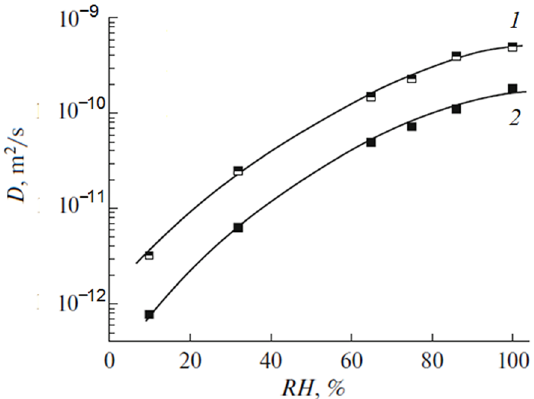
Figure 20. Average diffusion coefficients of water molecules and H + cations measured by pulsed field gradient NMR (1) and calculated from the proton conductivity data according to Equation (7) (2) in the H + form of the MSC membrane at different moisture contents. When RH = 100% the membrane is in contact with water. Reprinted with permission from Ref. [34]. Copyright © 2022 Pleiades Publishing, Ltd.